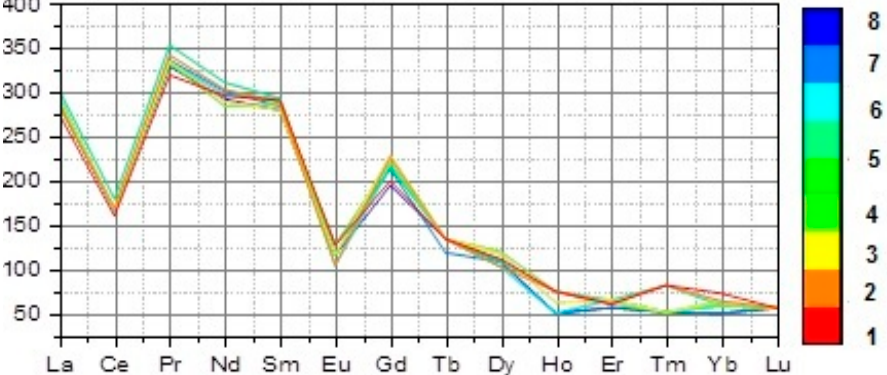
Figure 6. UCC-normalized REE diagram [26] for the studied